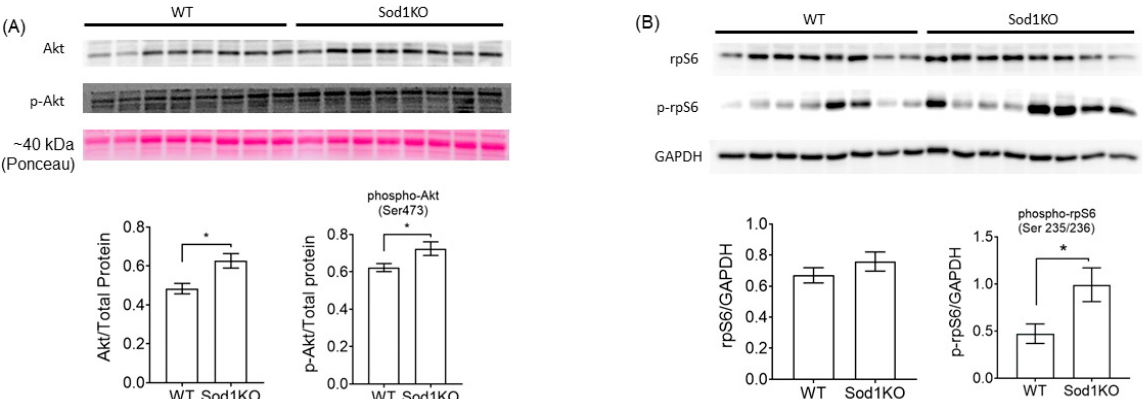
Figure 4. Sod1KO hearts exhibited the upregulation of Akt and ribosomal protein synthesis. ( A ) Top: Immunoblot images for total Akt and phosphorylated Akt. Bottom: Quantified data for total Akt and phosphorylated at Ser473, normalized by total proteins, were increased in Sod1KO hearts ( n = 8). ( B ) Top: Immunoblot images for total rpS6 and phosphorylated rpS6. Bottom: quantified data for rpS6 and phosphorylated rpS6 at Ser235/236 normalized by GADPH ( n = 8). * p < 0.05. Data are mean ± SEM. Abbreviations: Akt = serine–threonine kinase; rpS6 = ribosomal protein synthesis S6.